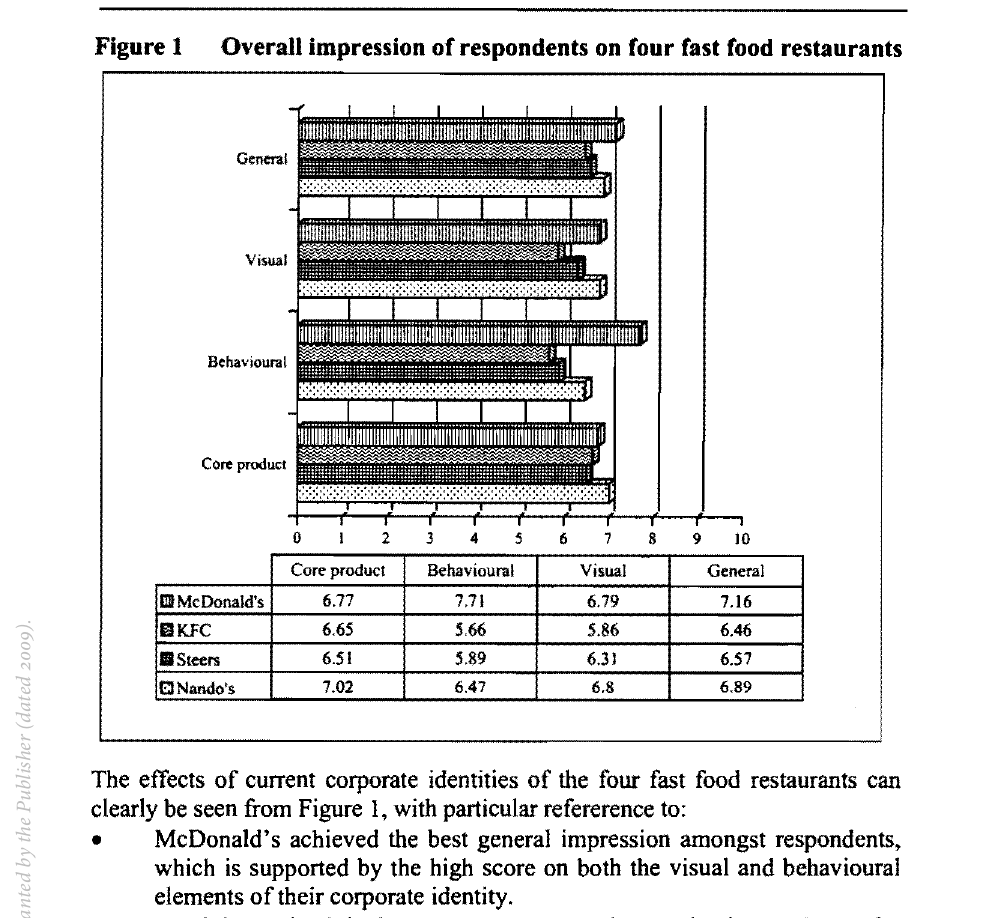
Overall impression of respondents on four fast food